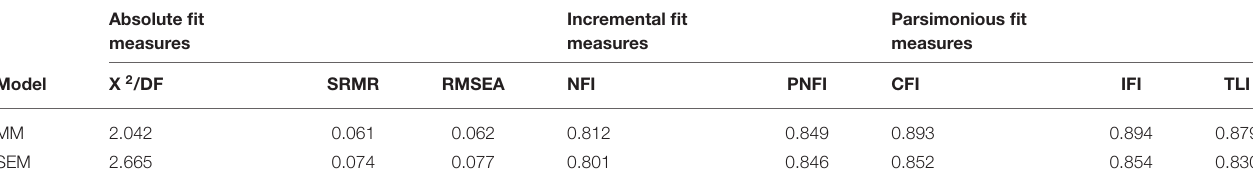
TABLE 5 | Comparison measure model and structural